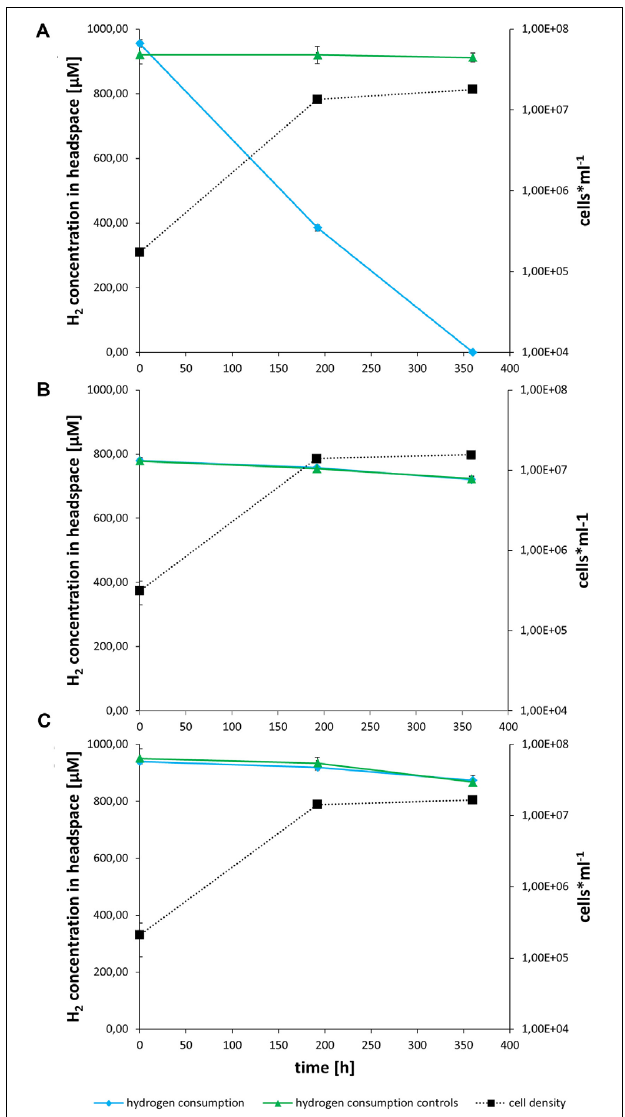
FIGURE 4 | In vivo hydrogen consumption and growth of the MJ enrichment culture on MJ (A) , MJ-T (B) and T-ASW (C) medium. Hydrogen consumption of the cultures is shown in blue with diamonds, controls containing only the respective medium in green with triangles and cell number of the cultures as dotted line in black with squares. The experiments were performed in triplicate, followed by polymerase chain reaction and sequencing of 16S rRNA and hynL genes (Hansen and Perner, 2015). Hydrogen consumption was determined by using gas chromatography and cell numbers were detected as described before (Hansen and Perner,